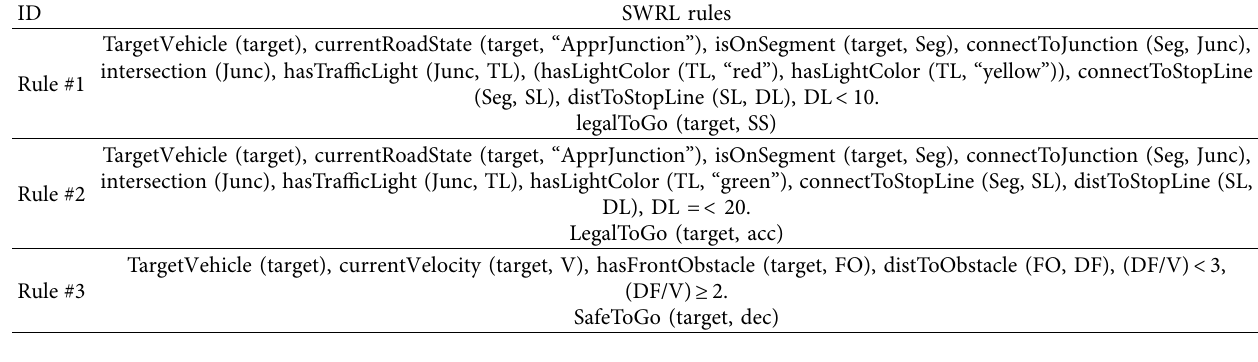
Table 1: Prediction rules used in this study.